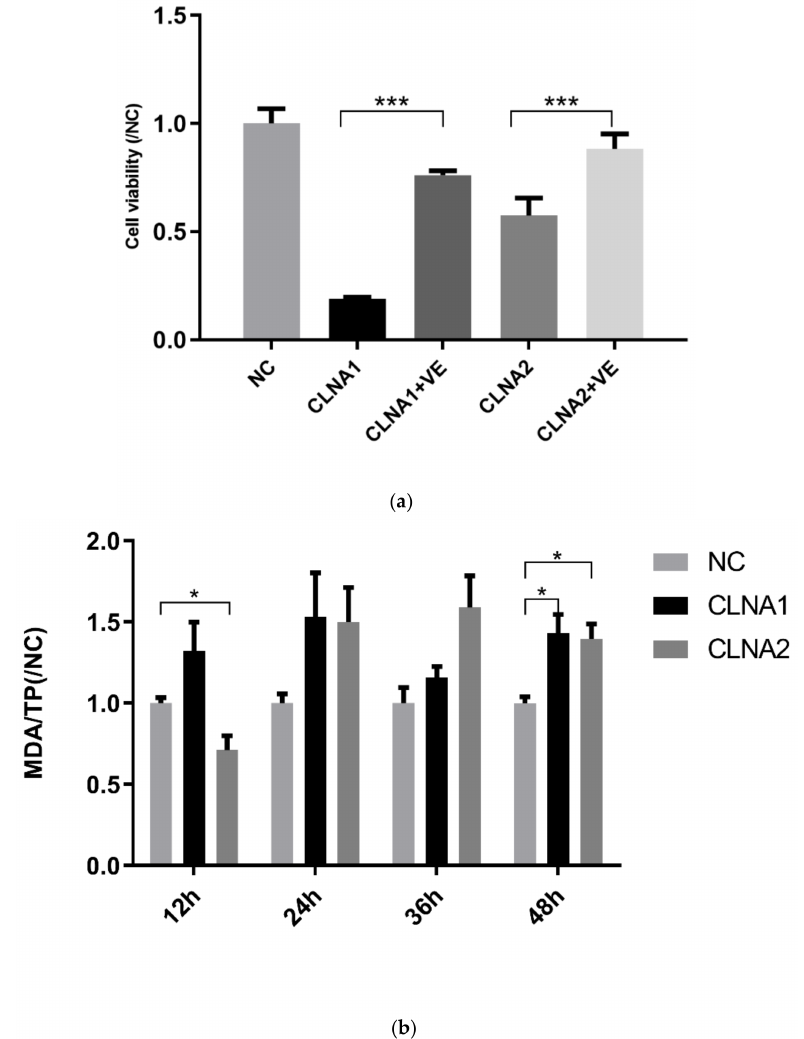
Figure 4. Induction of lipid peroxidation by CLNA1 and CLNA2 in Caco-2 cells. ( a ) The e ff ects of inhibitor VE on the Caco-2 cells treated with CLNA1 and CLNA2, respectively ( n = 6). ( b ) The changes of MDA protein expression in Caco-2 cells during the treatment with CLNA isomers ( n = 3). NC indicated control group without CLNA treatment. Data are presented as mean ± SEM and at least three separate experiments in all studies. * p < 0.05, ** p < 0.01 and *** p < 0.001 compared with